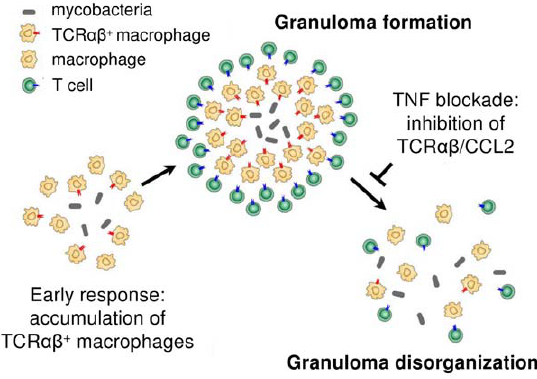
Figure 9. Proposed role of the macrophage recombinatorial TCR ab in the formation of the tuberculous granuloma and its regulatory interactions with TNF and CCL2.